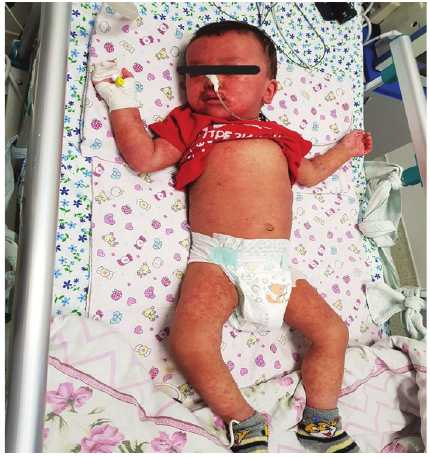
Figure 3 - Measles in a child of 12 months, the 6th day of the